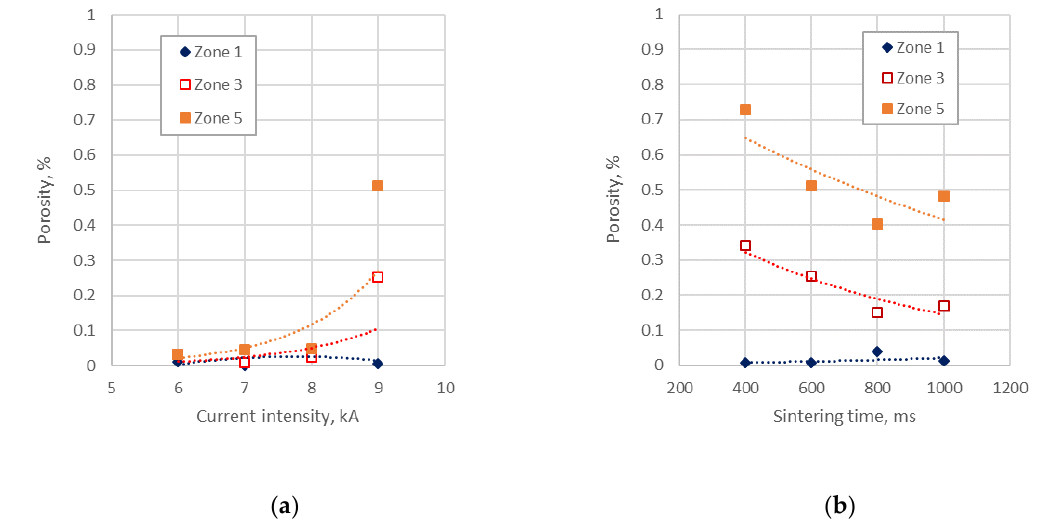
Figure 4. MF-ERS compacts porosity at zones 1, 3 and 5 as a function of ( a ) current intensity (experiences carried out at 600 ms), and ( b ) sintering time (experiences with 9 kA). Dotted lines are the trend lines of the different series.